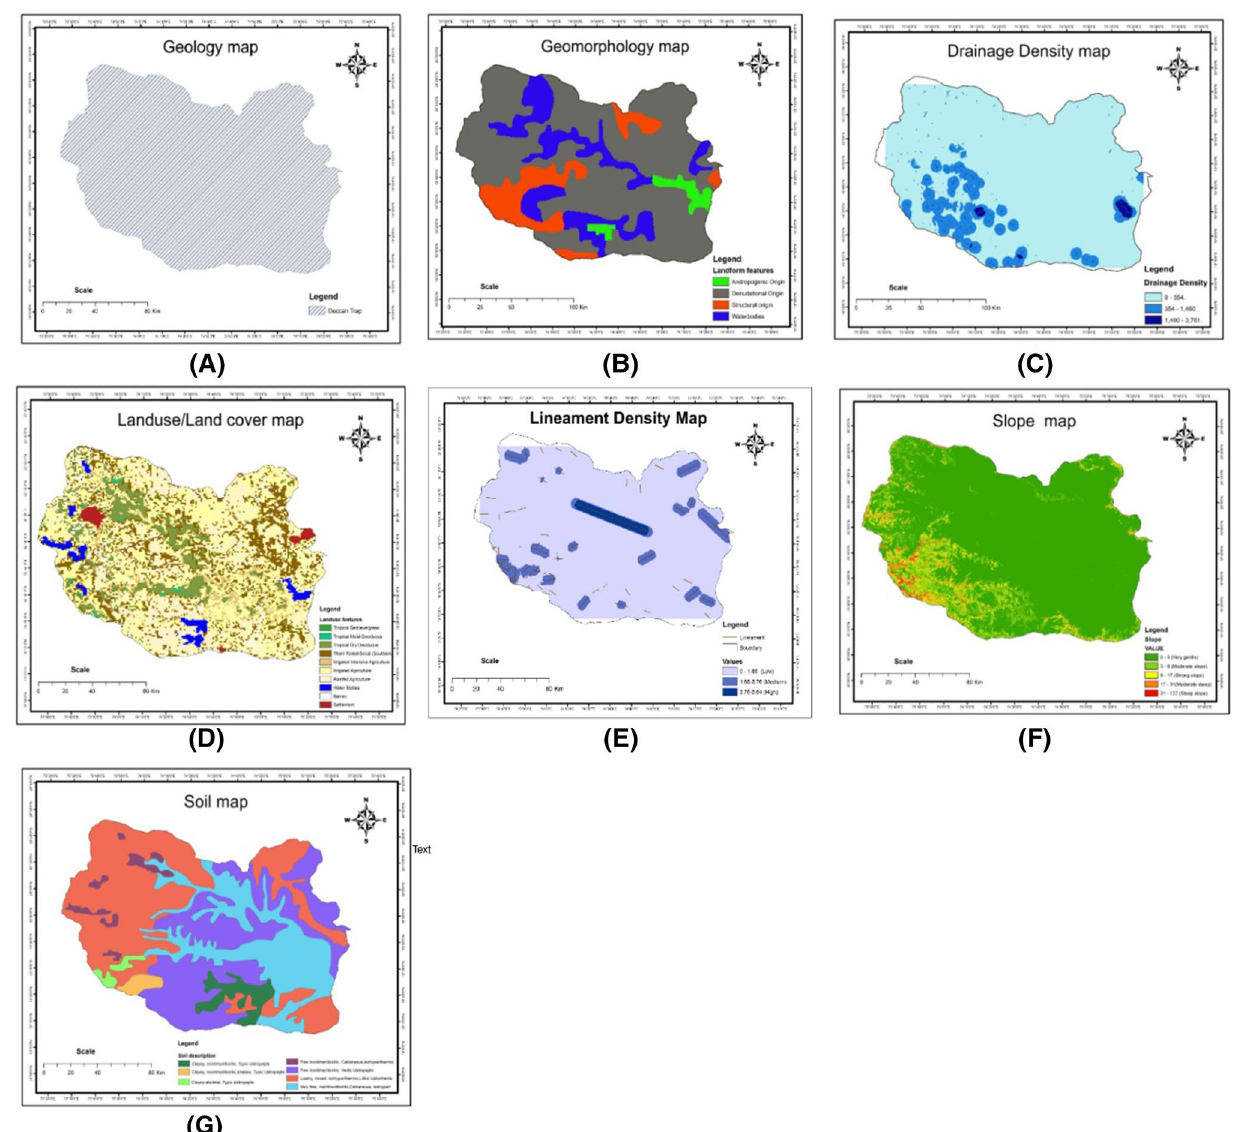
Fig. 3 Thematic maps: A geology, B geomorphology, C drainage density, D LULC, E lineament density, F slope, G soil